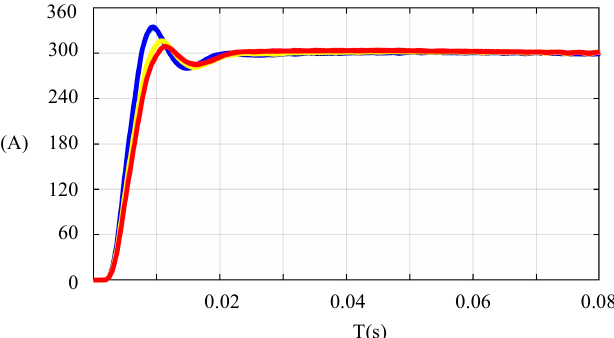
Figure 12. Output current waveform of the three modules in parallel mode.